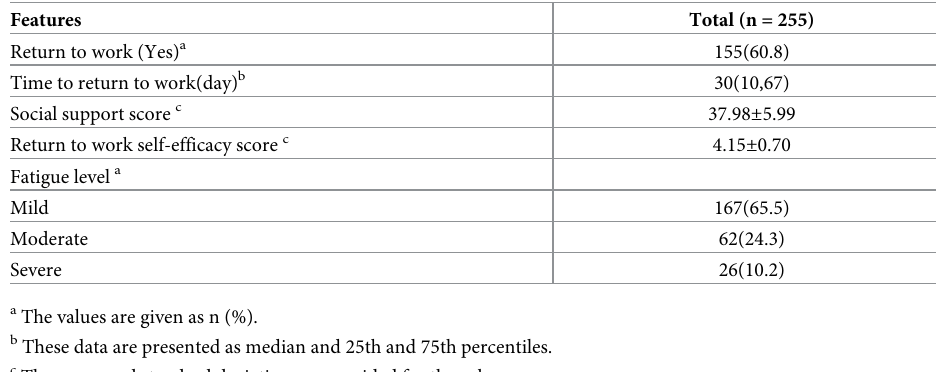
Table 2. Status of return to work, social support, return to work self-efficacy, and